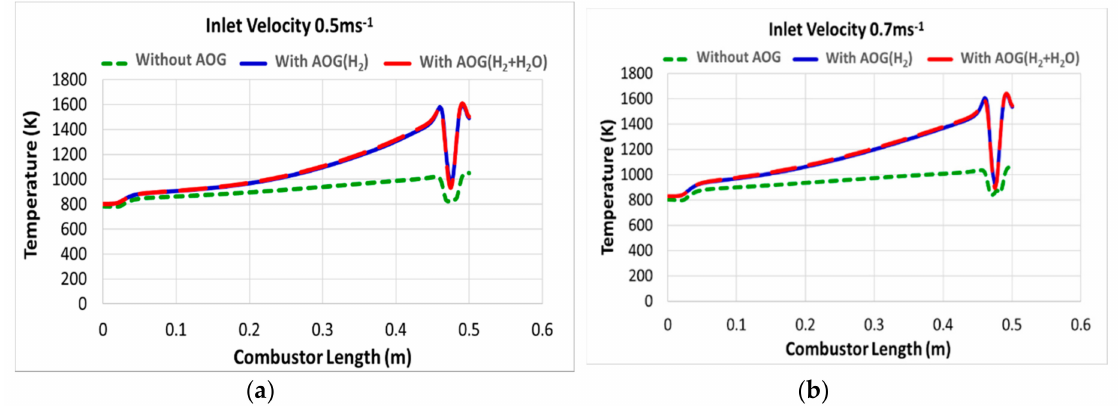
Figure 8. Line plots of temperature along the combustor length at ( a ) 0.5 m / s and ( b ) 0.7 m / s inlet velocity for all the three